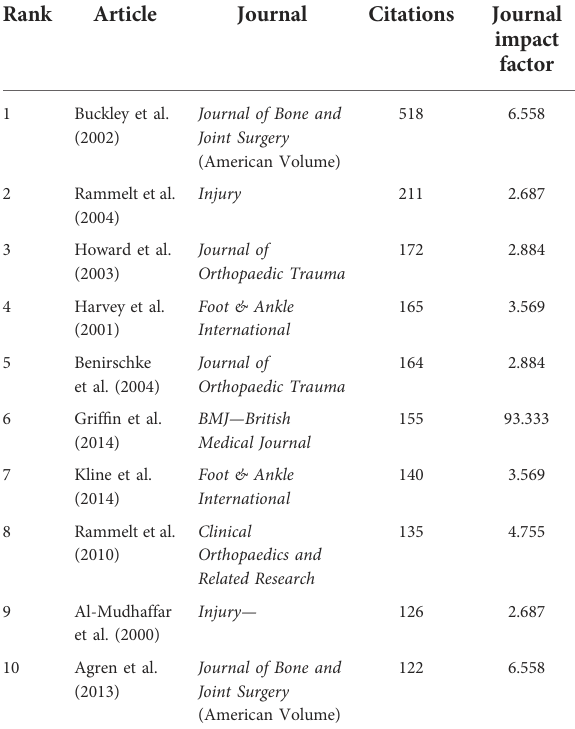
TABLE 1 Analysis of the top 10 cited articles in the fi eld of calcaneal